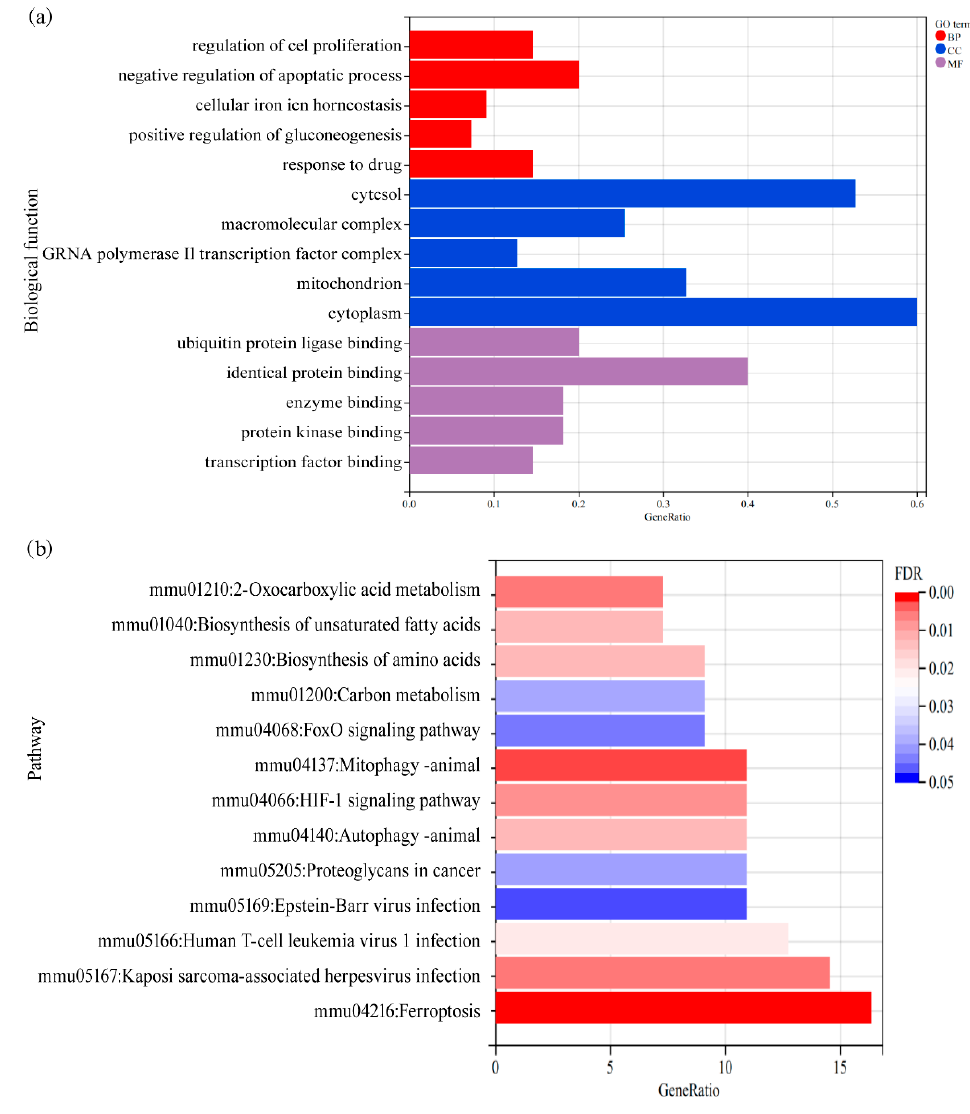
Figure 3. Results of molecular function and pathway enrichment analysis. ( a ) Function enrichment analysis (GO: gene ontology, BP: biological process, CC: cell component and MF: molecular function); ( b ) signal pathway enrichment analysis. FDR: false discovery rate.